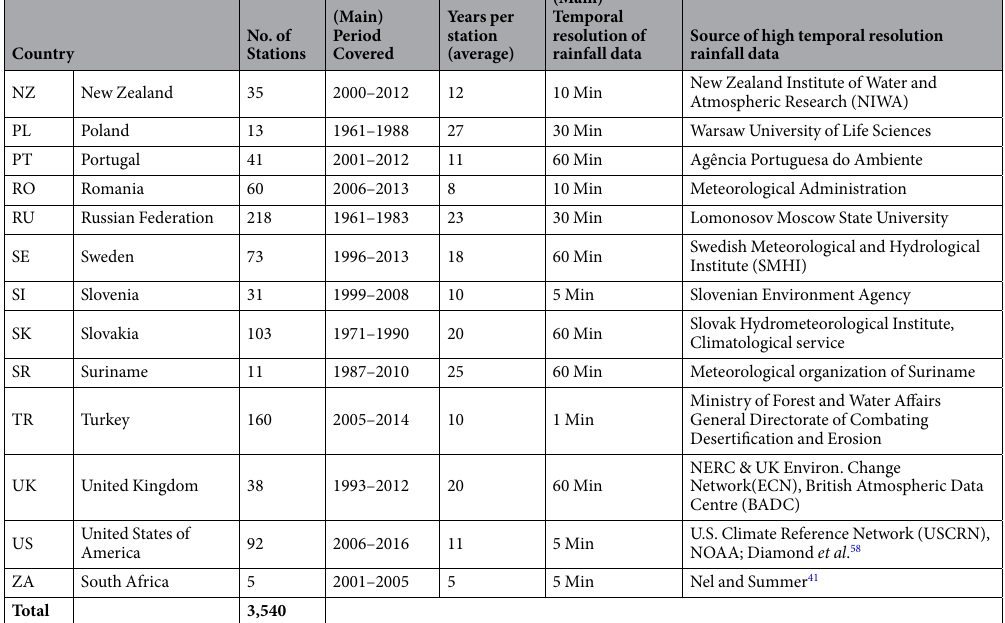
Table 2. Overview of the high resolution rainfall data used to estimate global rainfall erosivity. In addition, erosivity information of 85 stations from 13 countries found in the literature 24, 43–56 was included in the global map (not shown in the